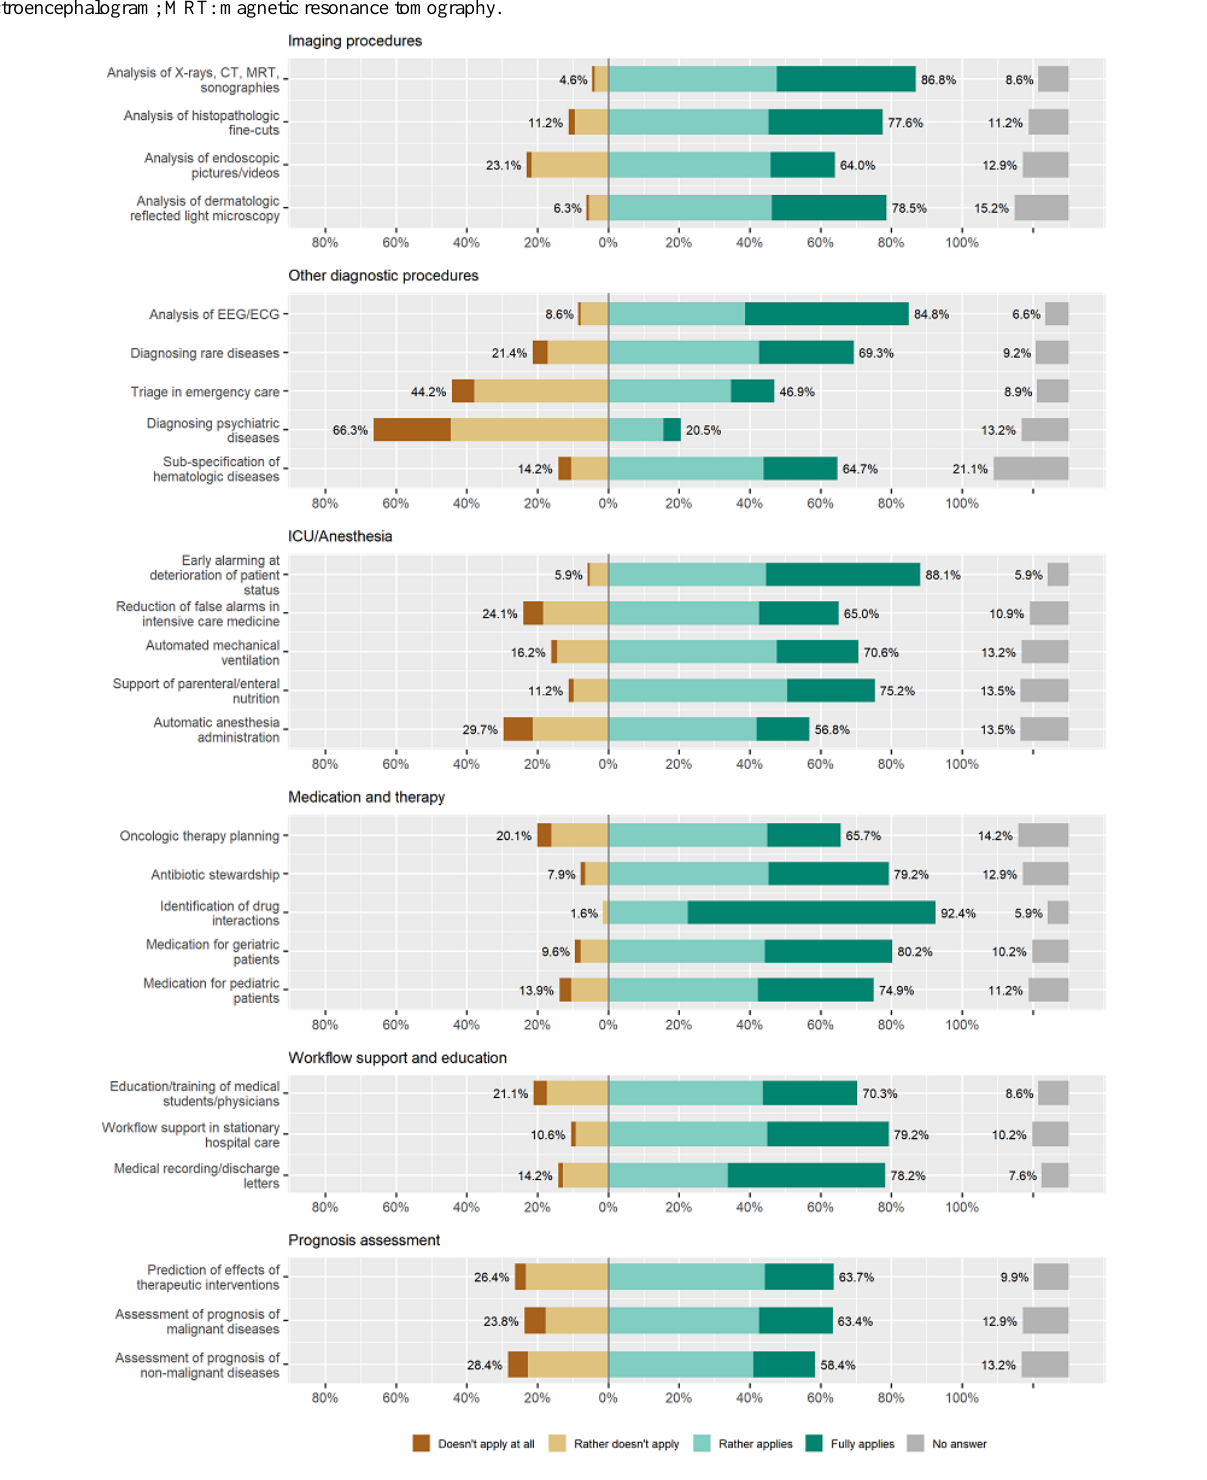
Figure 5. Artificial intelligence (AI) applications and potential for the future of medicine. CT: computed tomography; ECG: electrocardiogram; EEG: electroencephalogram; MRT: magnetic resonance